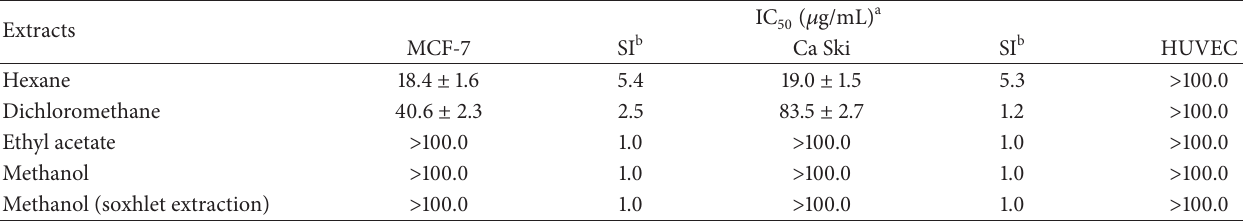
Table 1: Antiproliferative activity [IC values ( 𝜇 g/mL)] and selectivity index of crude and fractionated extracts of Curcuma zedoaria against 50 human cancer and noncancer (HUVEC) cell